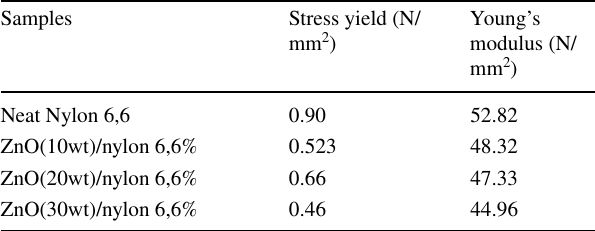
Table 1 Mechanical properties of neat polymer and ZnO/nylon 6/6 Samples